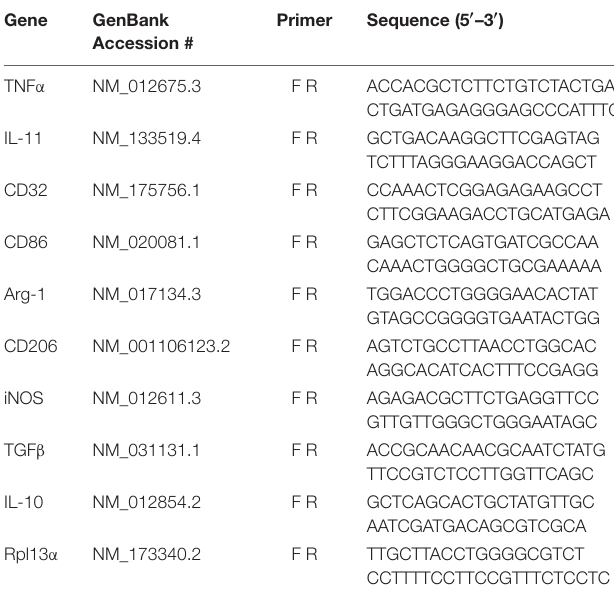
TABLE 1 | RT-qPCR Primer